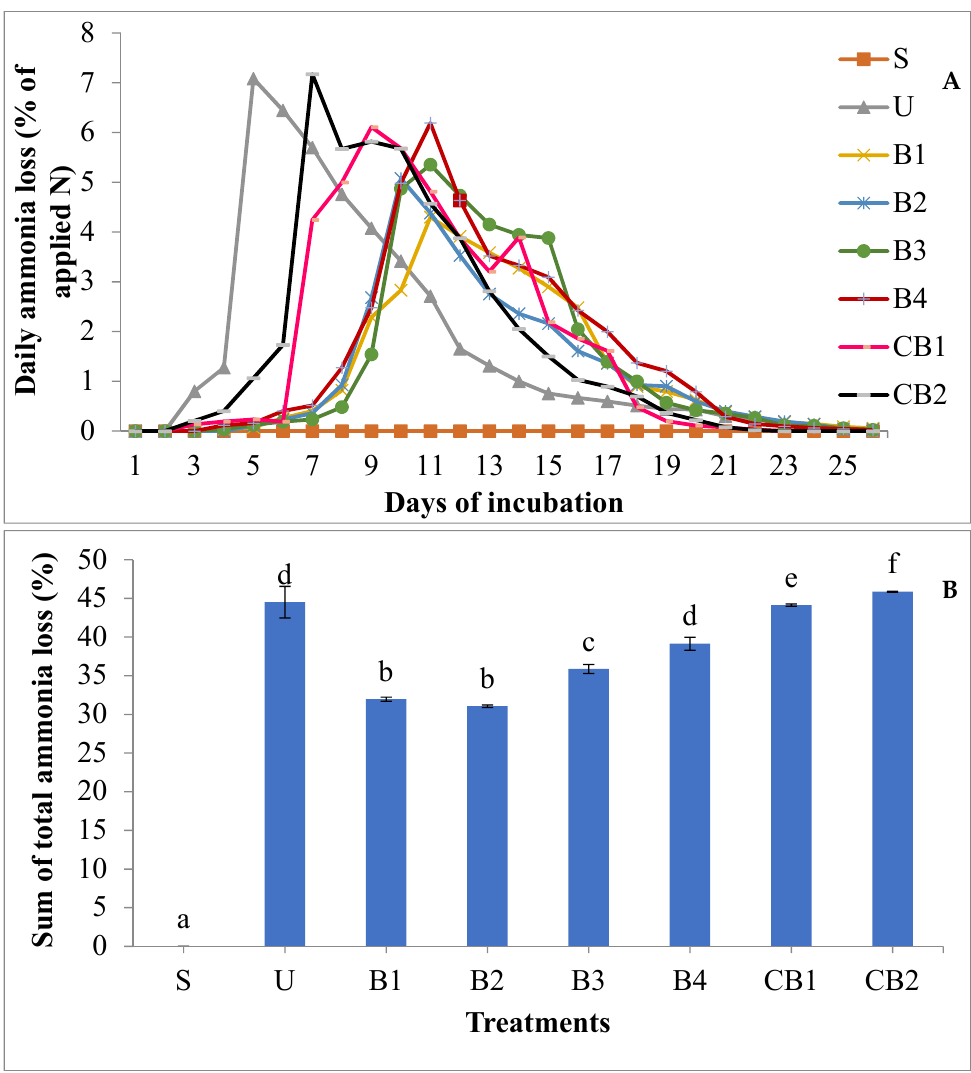
Figure 2. ( A ) Daily ammonia loss during 26 days of incubation study, and ( B ) sum of total ammonia loss in incubation study under waterlogged conditions. Mean values with different letter(s) indicate significant difference between treatments by Tukey’s test at p ≤ 0.05. Bars represent the mean values ± SE. The treatments evaluated were: S: Soil only, U: Soil + 175 kg ha − 1 urea, B1: Soil + 175 kg ha −